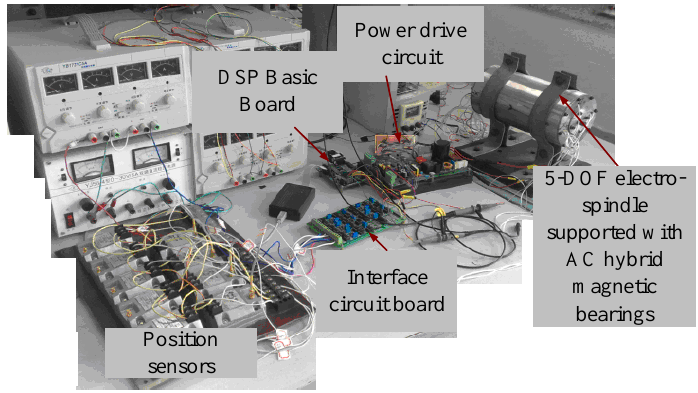
Figure 4. Experimental platform 5-DOF AC HMB-supported motorized spindle.